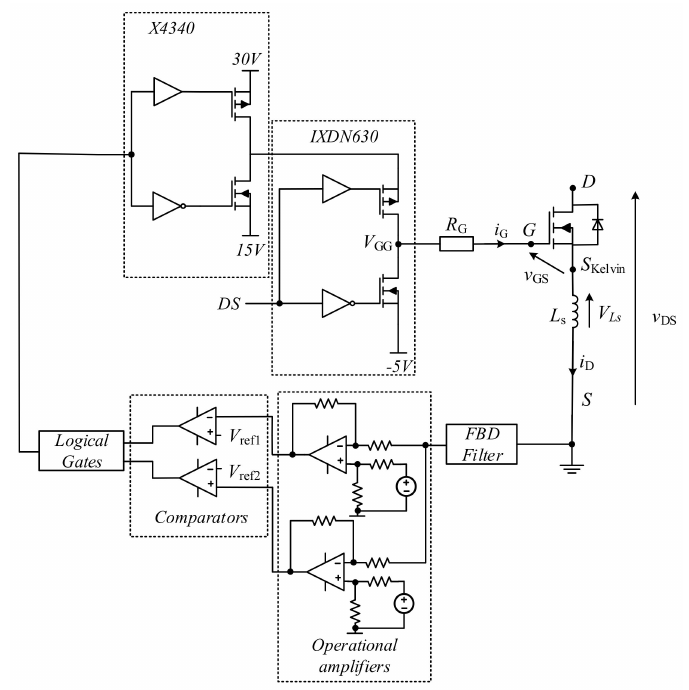
Figure 6. Simplified diagram of the